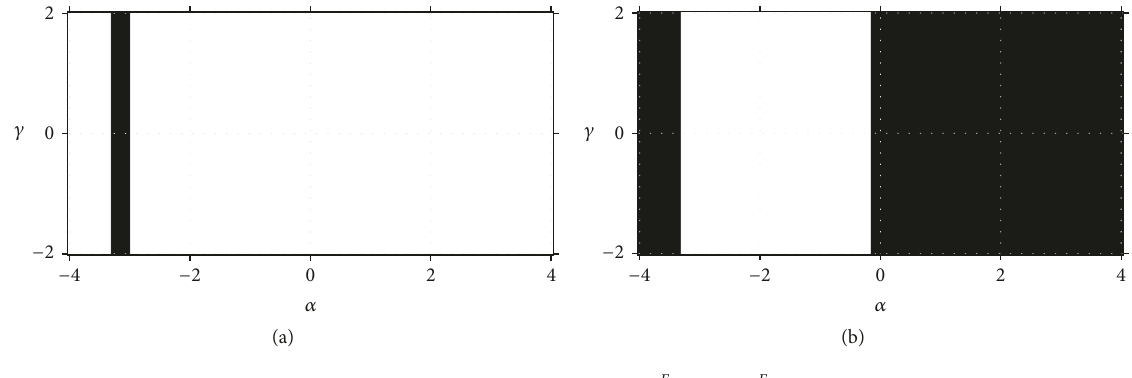
Figure 6: Stability plane of (a) 𝑥 𝐹 1 and (b) 𝑥 𝐹 2